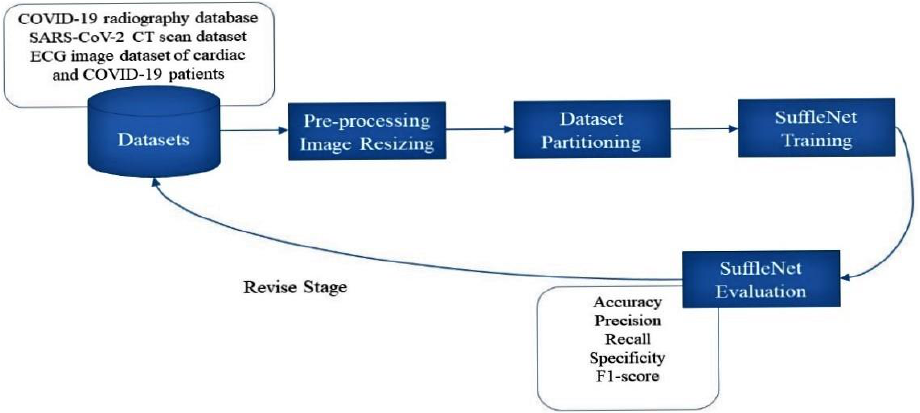
Figure 1. Overview of the proposed